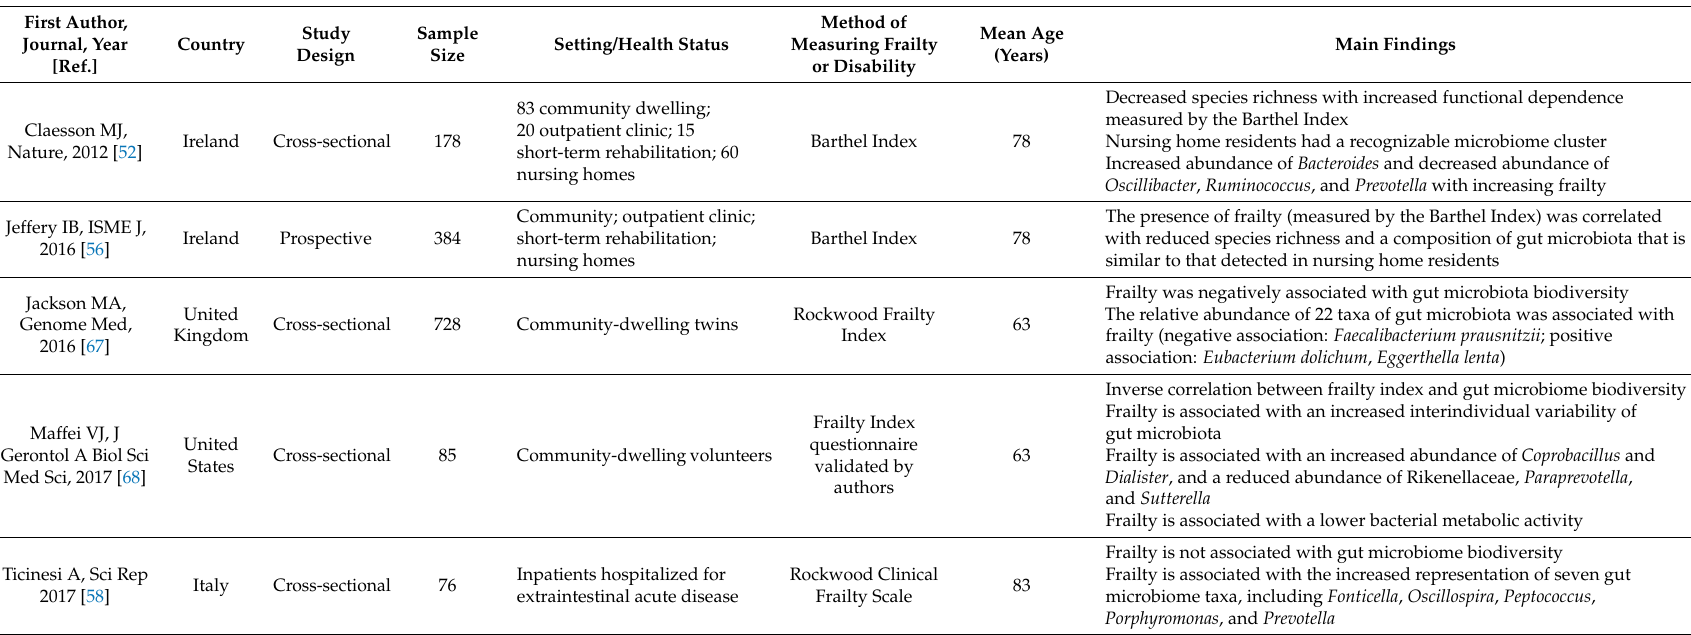
Table 2. Summary of studies exploring the association of fecal microbiota composition with frailty or disability in older